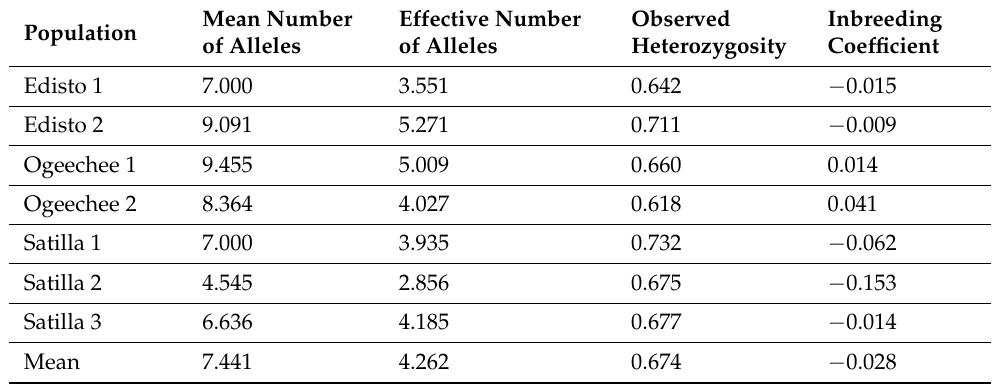
Table 2. Measures of genetic diversity based on microsatellite analysis at 11 loci within genetic clusters of Atlantic sturgeon from three rivers in the South Atlantic DPS: the Edisto, Ogeechee, and Satilla.